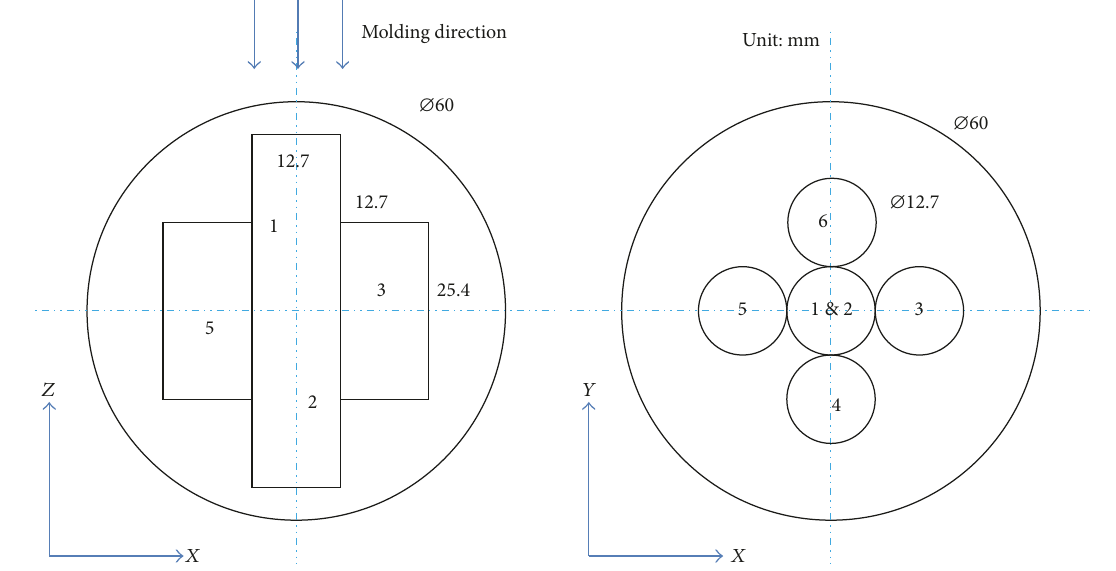
Figure 1: Schematic for the machining of specimens from a MG pebble.